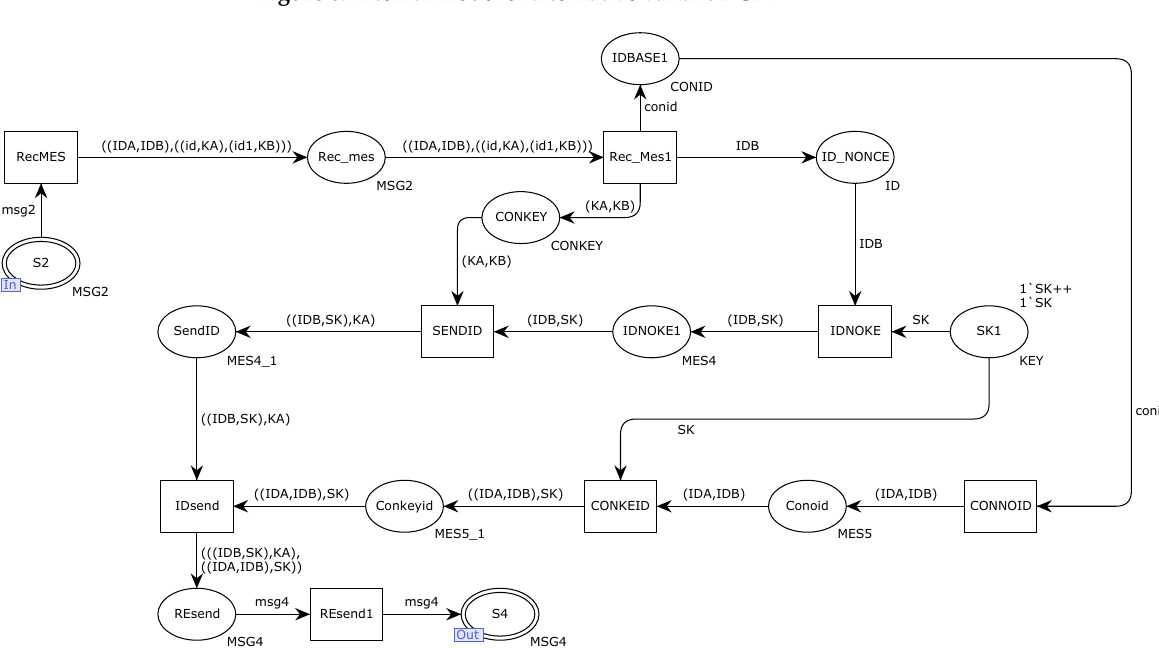
Figure 6. Internal model of alternative variant DCB.